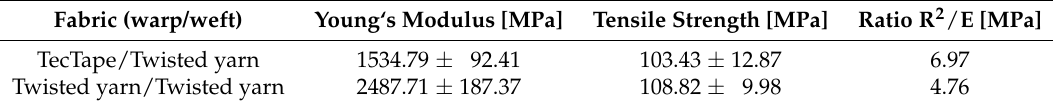
Table 5. Experimental results from tensile tests for flexure hinge specimens with CI of 95%.